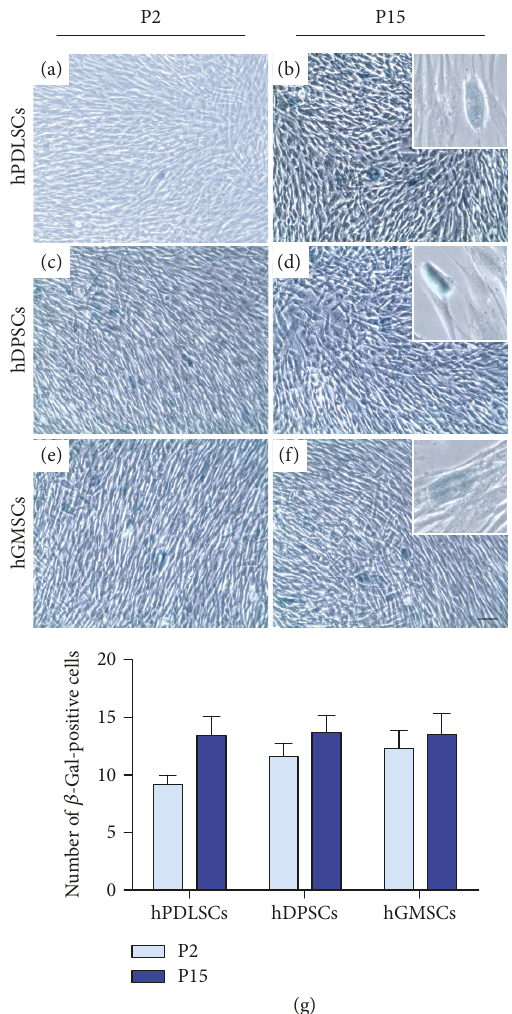
Figure 3: Senescence-associated β -galactosidase staining. (a, c, and e) hPDLSCs, hDPSCs, and hGMSCs from P2 were stained with X-gal solution. (b, d, and f) hPDLSCs, hDPSCs, and hGMSCs at P15 were stained with X-gal solution and showed low levels of blue precipitation (Mag.: 10x). (b, d, and f) X-gal positive staining of hPDLSCs, hDPSCs, and hGMSCs at high magni fi cation (Mag.: 40x). (g) Percentage of β -gal-positive cells. Results are representative of three independent experiments. Bar: 10 μ